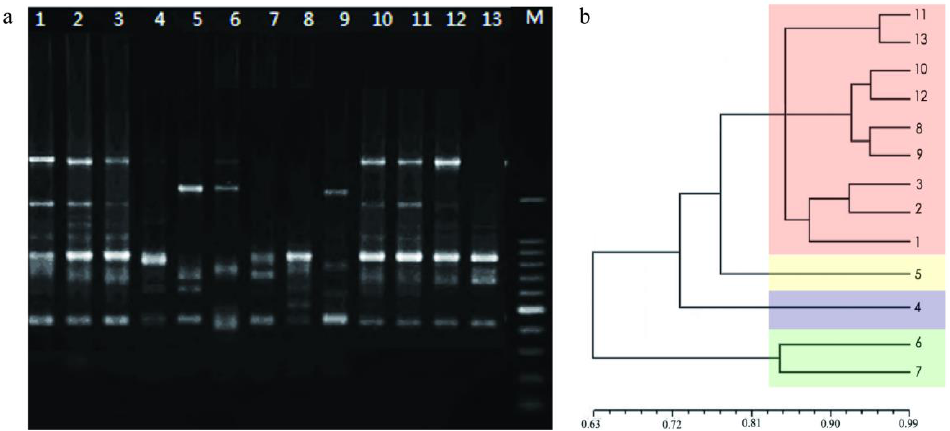
Figure 4. ISSR analysis results. ( a ) ISSR amplification patterns performed by primer 810; ( b ) Dendrogram generated by UPGMA method based on genetic similarity from ISSR marker in Radix bupleuri materials.